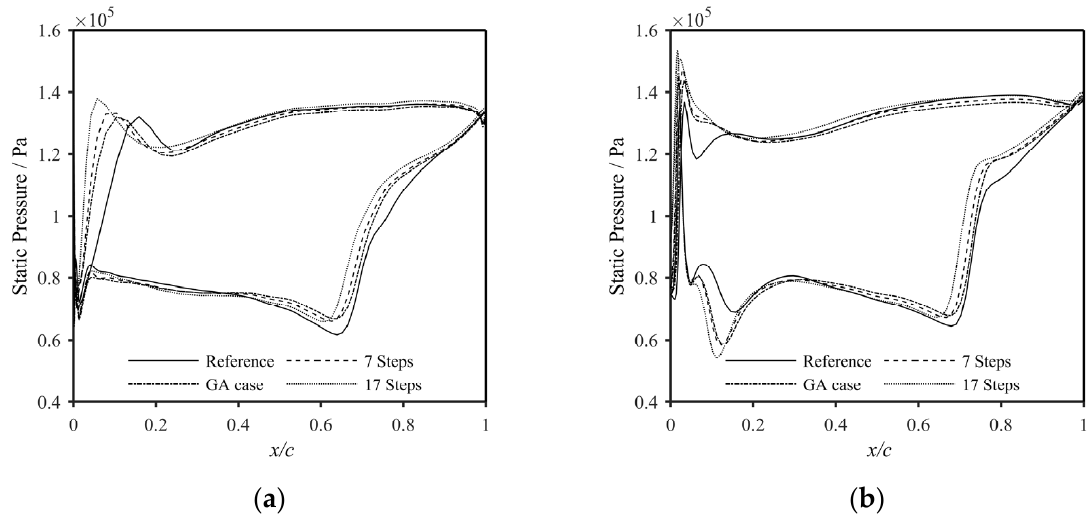
Figure 21. Static pressure distribution through the chord line near and around the tip span: ( a ) 90% span; ( b ) 99.8% span. span; ( b ) 99.8%